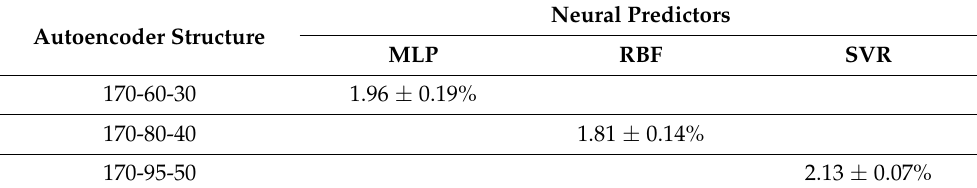
Table 2. Mean values of MAPE testing error for three individual neural predictors cooperating with an autoencoder (number of hidden neurons of MLP was 40, in RBF 50, σ = 0.5, ε = 0.01, and C = 3000 in